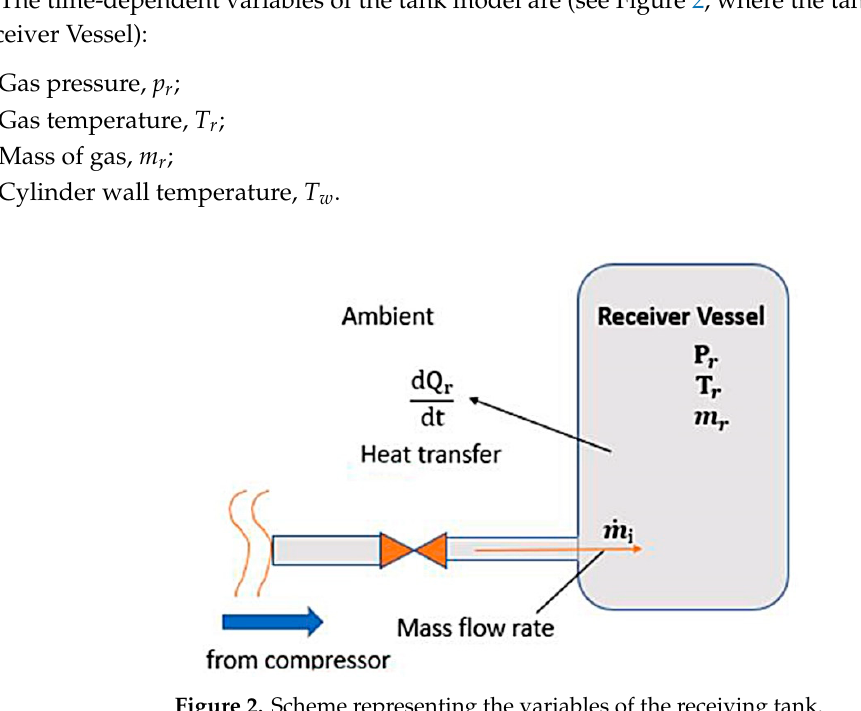
Figure 2. Scheme representing the variables of the receiving tank.